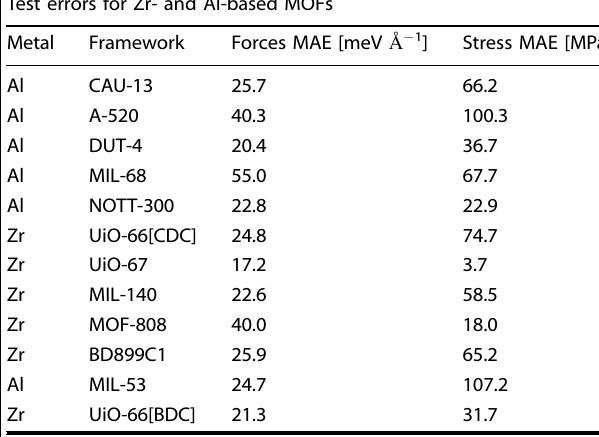
Table 1. Test error performance of an MLP trained on a set of 10 aluminum- or zirconium frameworks (not including UiO-66(Zr) and MIL-53(Al)) at 600 K. Test errors for Zr- and Al-based